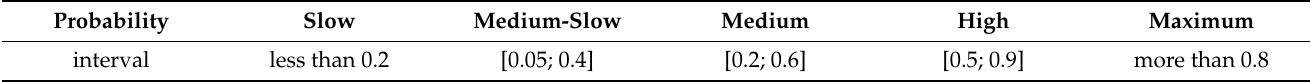
Table 4. Probability that risk factors will manifest themselves and the corresponding linguistic variable.